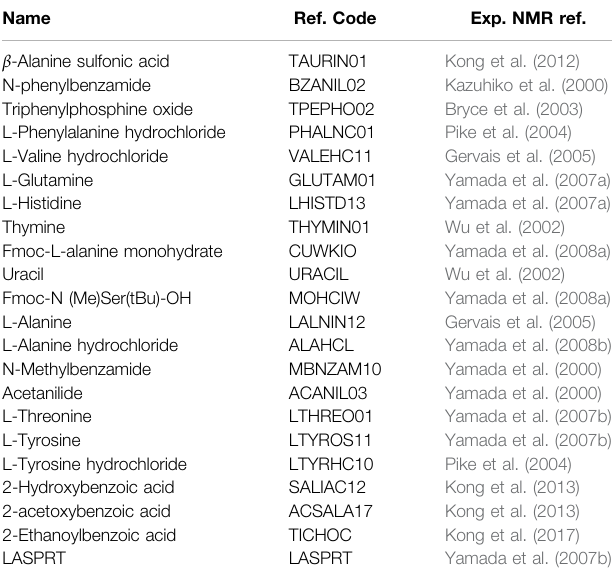
TABLE 2 | Chemical name, CSD reference code, and experimental NMR reference for all crystal structures included in the 17 O benchmark study.